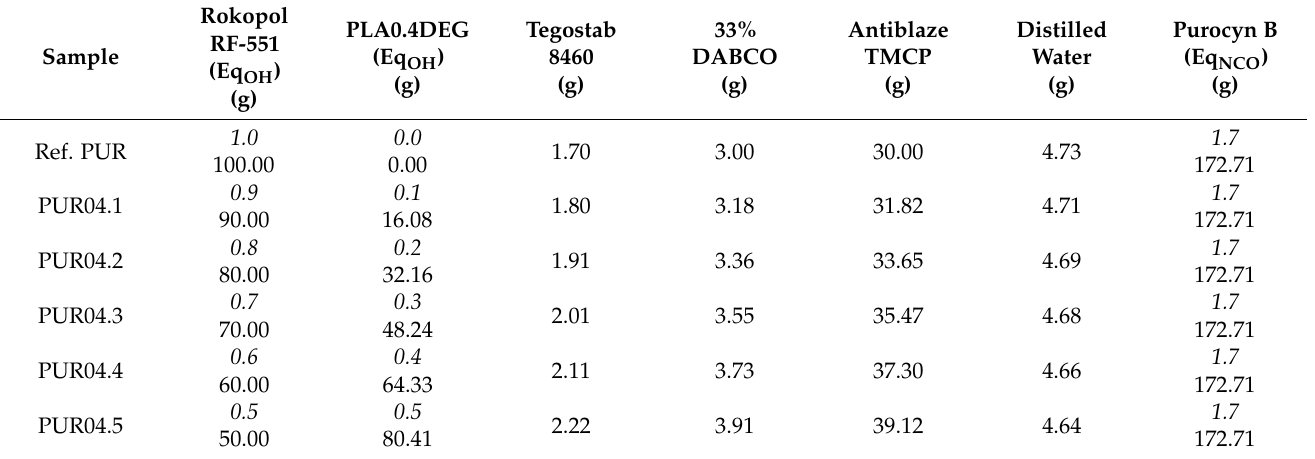
Table 8. Formulation of RPU foams with PLA0.4DEG eco-polyol.